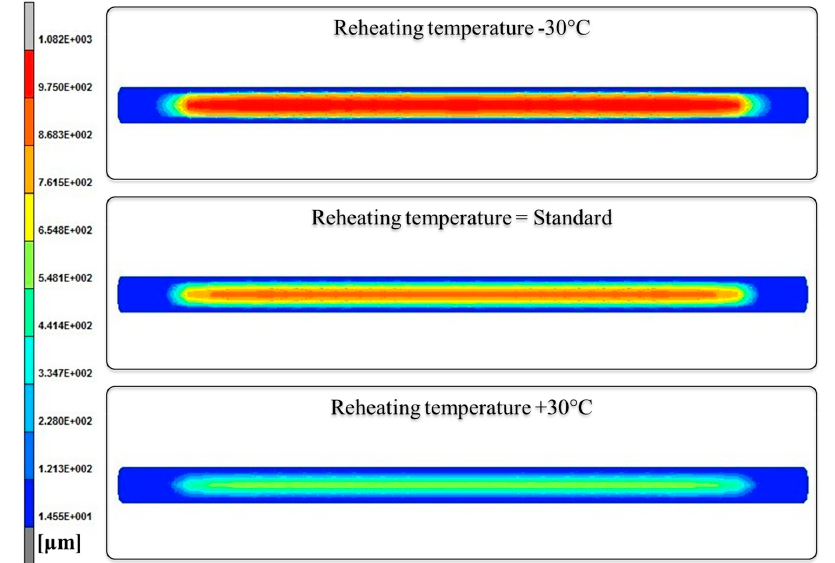
Figure 10. Effect of the reheating temperature on the ferrite grain size after the fifth roughing pass.